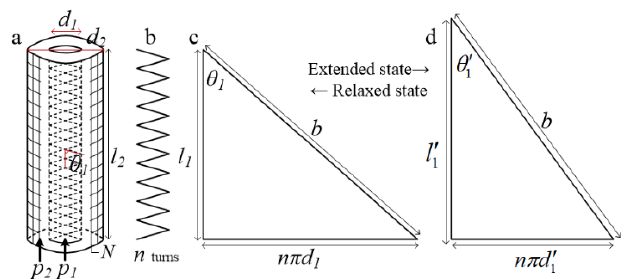
Figure 4. Parameter drawings of the soft actuator concept. ( a ) Geometry parameter of actuator. ( b ) A single-turn yarn of woven fabric outer the contractor muscle. A right triangle formed by the length of a single-turn yarn as a hypotenuse, ( c ) is under relaxed state and ( d ) is extended